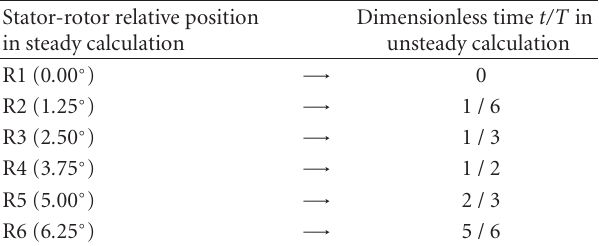
Table 1: Corresponding relationship between stator-rotor relative position and dimensionless time t/T .